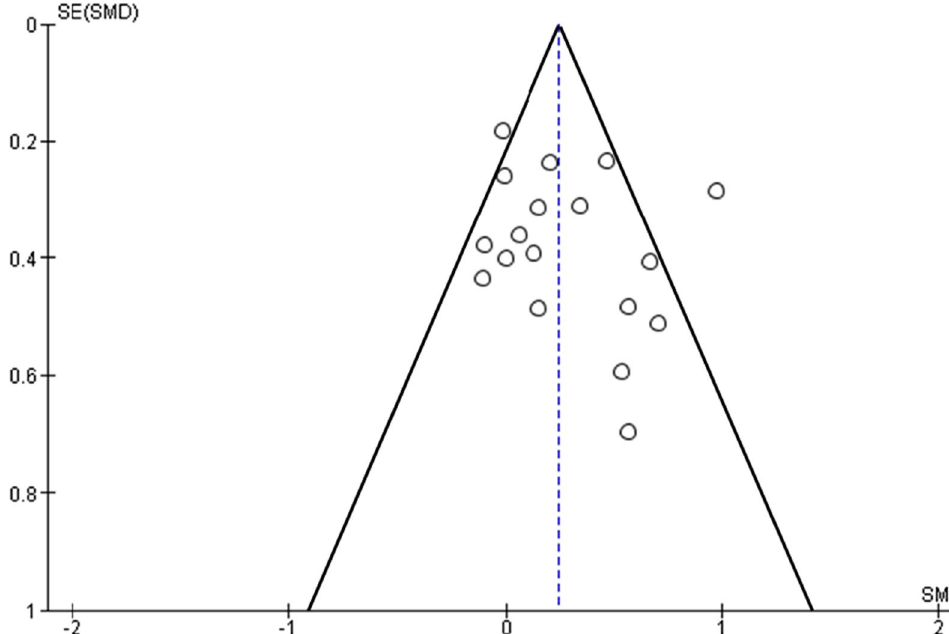
Fig. 9 Effect size and standard error funnel